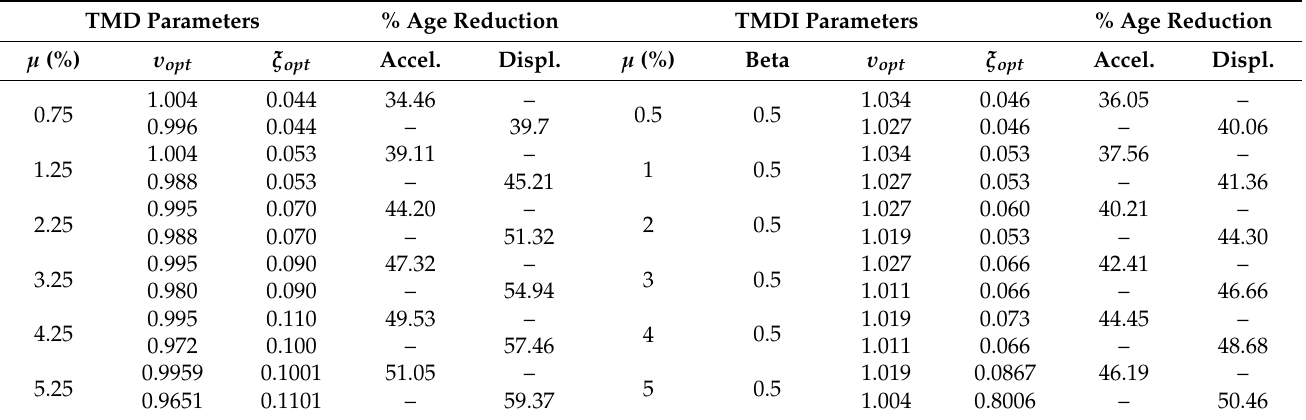
Table 3. Optimal parameters of the TMDI and the equivalent TMD, under variable frequency excitation, for different mass ratios.